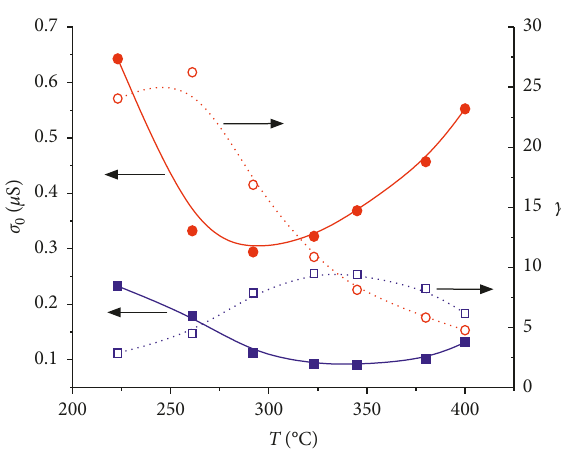
Figure 4: Dependencies of conductivity in air ( σ 0 ) and response to hydrogen ( c ) of the sensors based on undoped SnO 2 (squares connected by blue lines) and Pd/SnO 2 (circuits connected by red lines) on the sensor operational